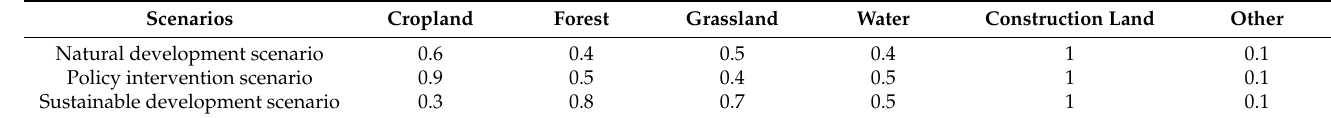
Table 2. The neighborhood factor parameters of the GeoSOS-FLUS